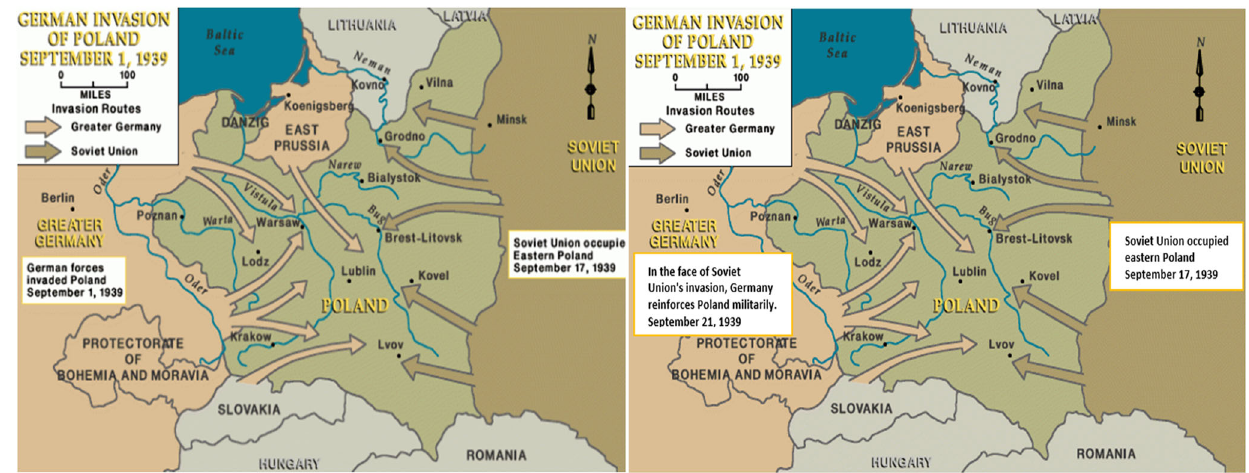
Fig. 1 Example of source used in both conditions: on the left, map of German Invasion in 1939 extracted from United States Holocaust Memorial Museum. Copyright of United States Holocaust Memorial Museum: https://encyclopedia.ushmm.org/. On the right, the same map with the modi fi cation of which country invaded Poland and its